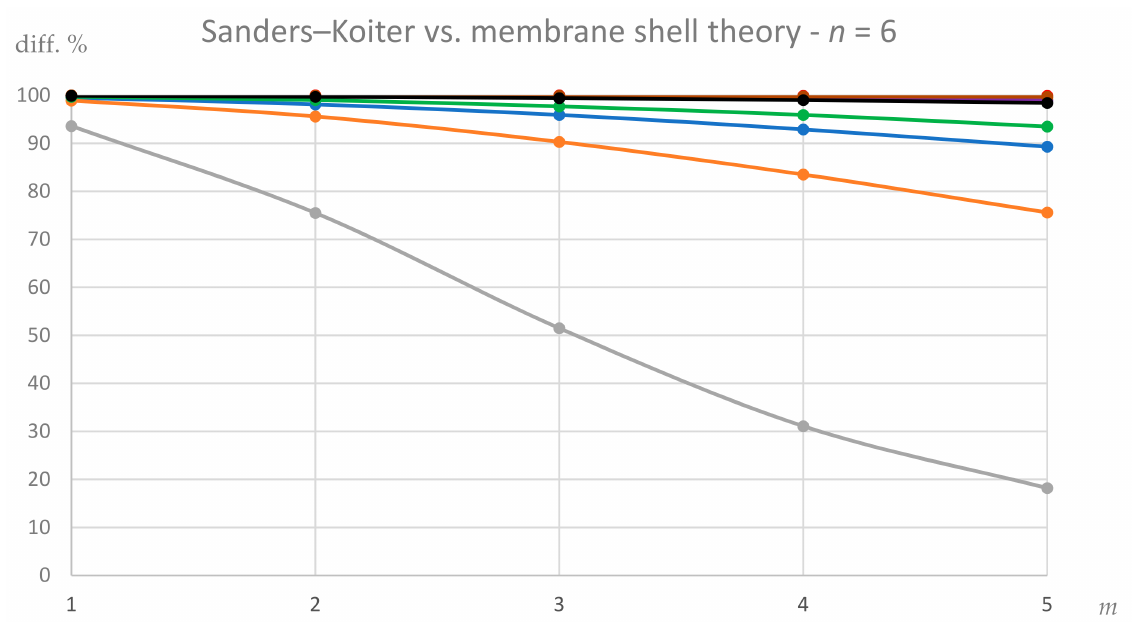
Figure 6. Simply supported DWCNT of Table 1 with different values of aspect ratio L / R 2 and thickness ratio R 2 / h . Shell- like modes ( n = 6). Comparisons between extended Sanders–Koiter and simplified membrane shell theories, where L / R 2 = 10, R 2 / h =